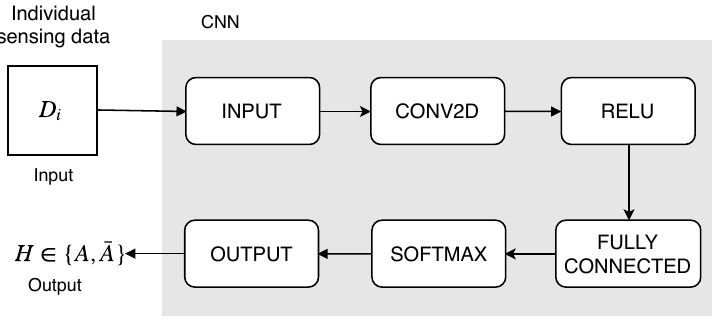
Figure 4. The structure of the convolutional neural network (CNN) for spectrum sensing in this